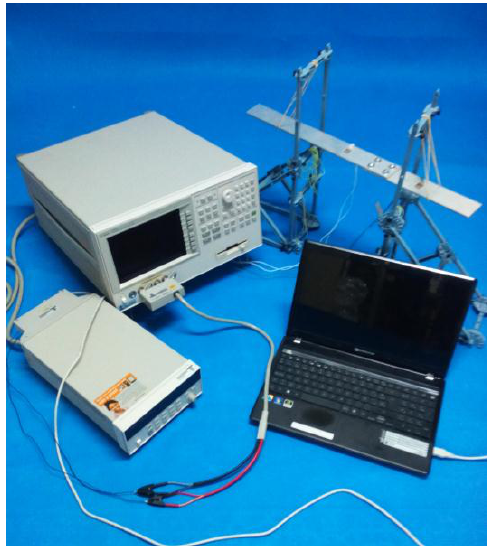
Figure 3. Experimental setup for impedance measurements on the bolt-jointed aluminium beam.